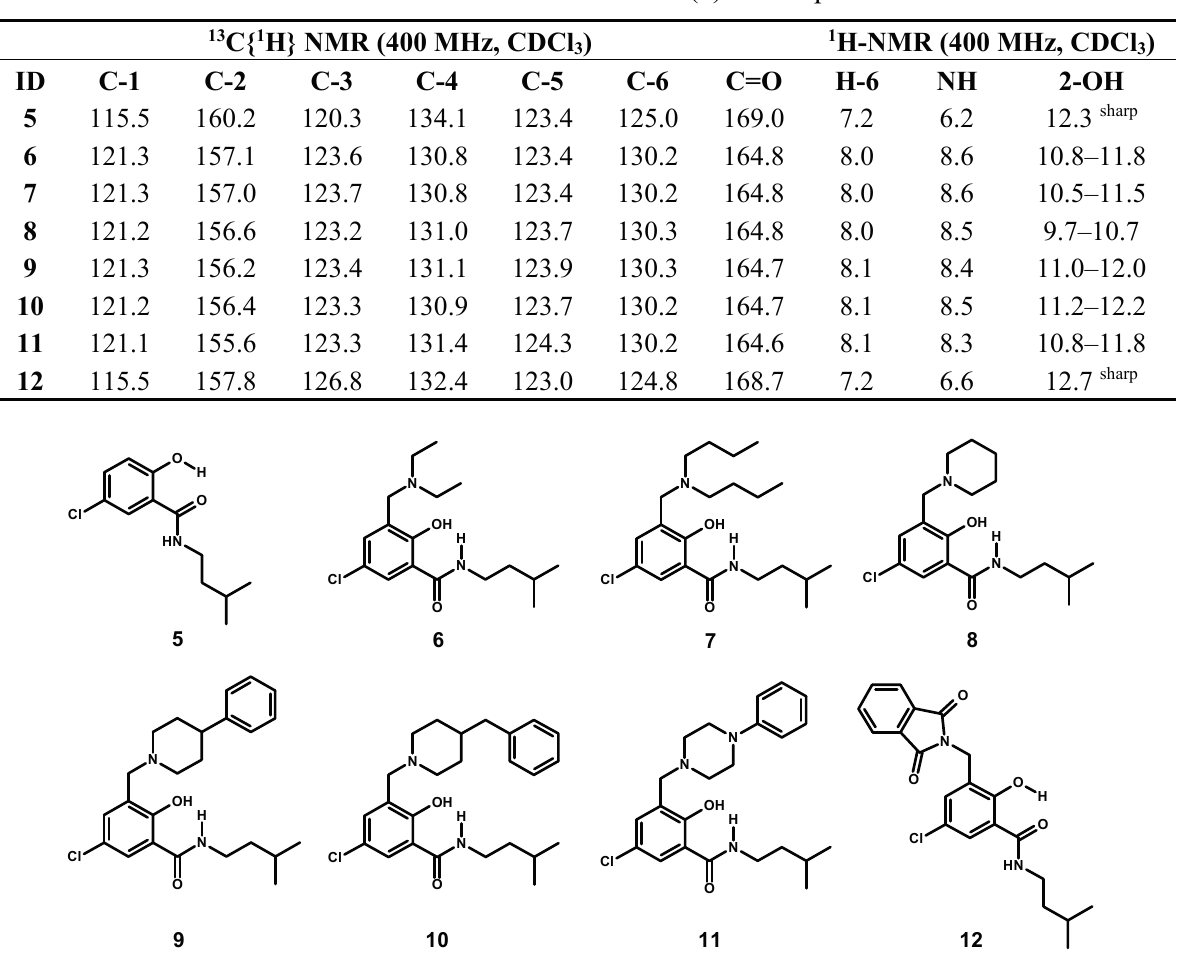
Figure 5. Structures of compounds 5 – 12